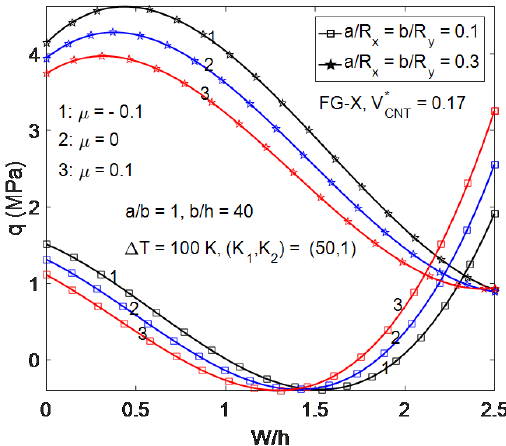
Fig. 14: Effects of curvature and temperature on the nonlinear re- sponse of FG-CNTRC spherical panels on elastic foundation with immovable edges.